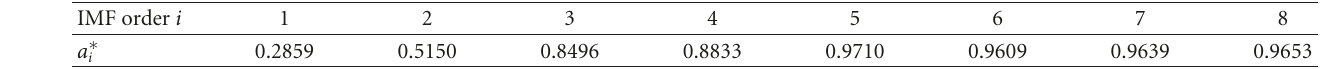
Table 1: Optimal coe ffi cients of the OSR algorithm.